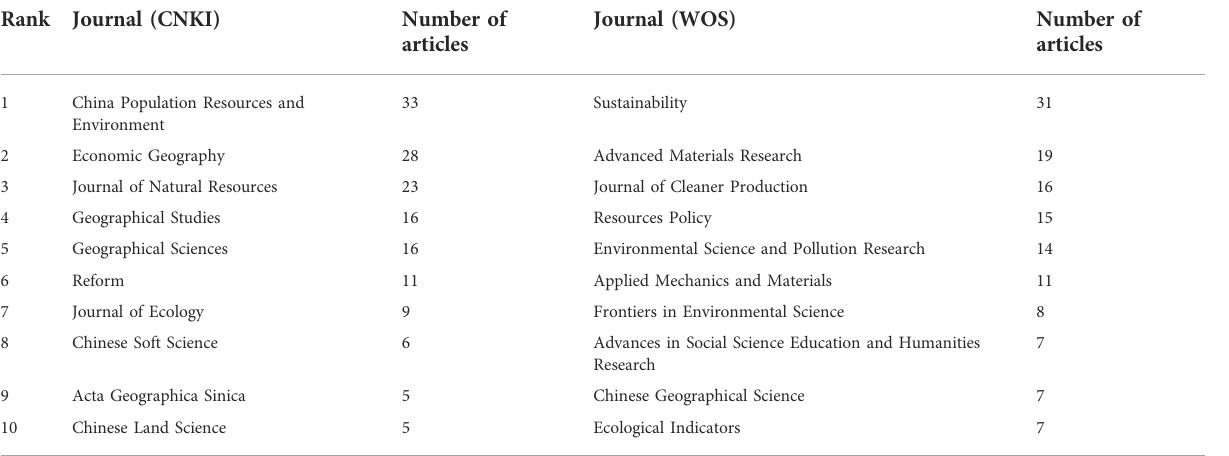
TABLE 1 Journal of resource-based city research (top